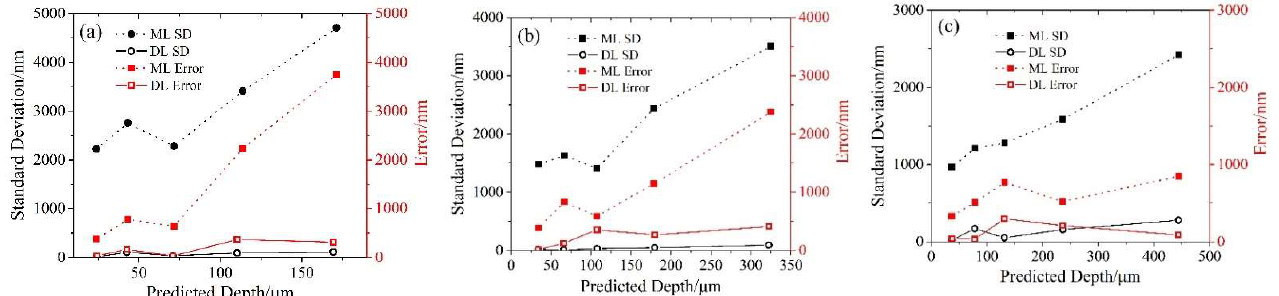
Figure 9. Standard deviation and error of depth results for widths of ( a ) 1.93 μm, ( b ) 10.3 μm, and ( c ) 30.3 μm, predicted by machine learning model (dot line) and deep learning model (solid line). ML, machine learning; DL, deep learning; SD, standard deviation.